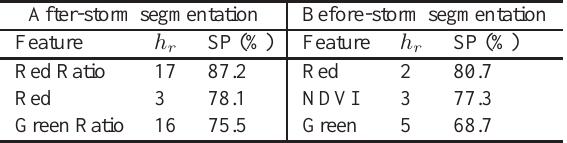
Table 2: Optimal features and spectral ranges h r for the after- storm and the before-storm segmentations using a test frame of 4 samples. SP is the segmentation performance ( cf. Eq. 1). Table 3: Optimal features for the binary classification using a test frame of 4 samples with h r = 2 .